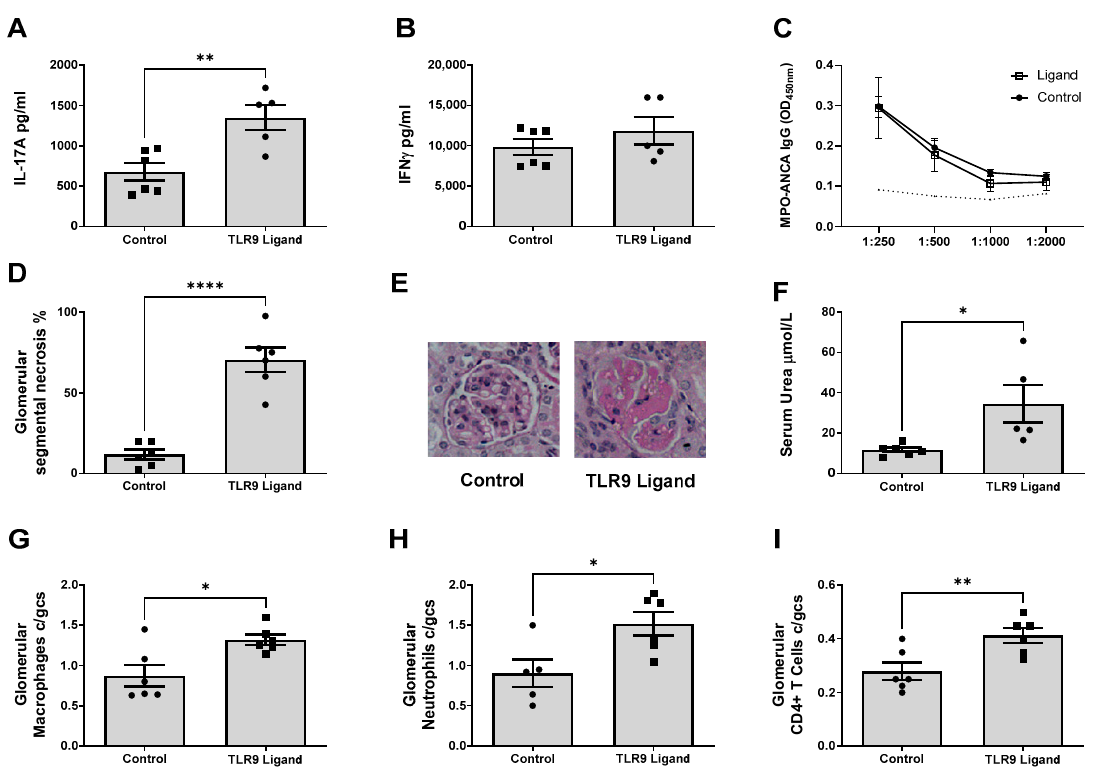
Figure 3. TLR9 ligation of MPO pulsed dendritic cells promotes late MPO autoimmunity, t cell recall responses and subsequent kidney injury. Immune responses (day 18): ( A ): Increased production of IL-17A in mice receiving TLR9 stimulated MPO pulsed DCs compared to control stimulated MPO pulsed DCs. ( B ): No significant increase in production of IFN- γ in mice receiving TLR9 stimulated MPO pulsed DCs at Day 18. ( C ): No difference in serum MPO-ANCA IgG in mice receiving TLR9 stimulated and control stimulated MPO pulsed DCs compared to OVA injected mice. Dotted line represents the OD 450 of sera from control, OVA immunized mice receiving anti-GBM globulin. Glomerular Injury Measurements: ( D , E ): Kidney injury as assessed by percentage of abnormal glomeruli on formalin fixed paraffin embedded periodic acid Schiff sections taken at original magnification ×400. Increased kidney injury in mice receiving TLR9 stimulated MPO pulsed DCs. ( F ): Serum urea measurement in µmol/L. Increased in mice receiving TLR9 stimulated MPO pulsed DCs. ( G ): Increase in glomerular macrophage recruitment, measured as average FA11+ cells per glomerular cross section (cells/glom) in mice receiving TLR9 stimulated MPO pulsed DCs. ( H ): Increase in glomerular neutrophil recruitment, measured as average Gr1+ cells per glomerular cross section (cells/glom) in mice receiving TLR9 stimulated MPO pulsed DCs. ( I ): Increase in glomerular CD4+ T Cell recruitment, measured as average GK1.5+ cells per glomerular cross section (cells/glom) in mice receiving TLR9 stimulated MPO pulsed DCs. Bars show the mean +/ − SEM. * = p <0.05, ** = p < 0.01, **** = p < 0.0001. DC = Dendritic cell. Mouse numbers for experiment: Control: n = 6, TLR9 Ligand: n = 6.